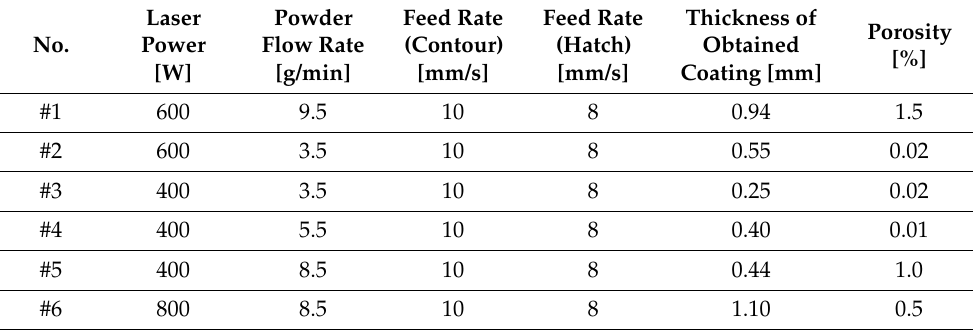
Table 1. The set of the best LENS process parameters used during deposition of Co-6 coatings.